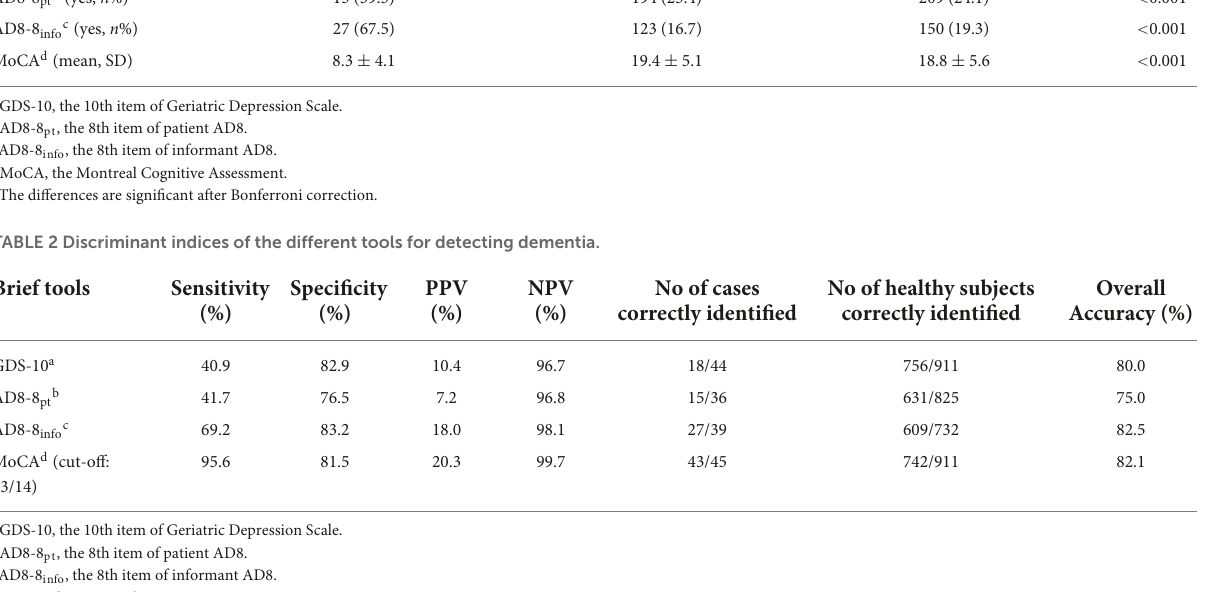
TABLE 3 Discriminant indices of the combination of single-question subjective cognitive complaints (SCC) with Montreal cognitive assessment (MoCA) for detecting dementia. Combination of brief